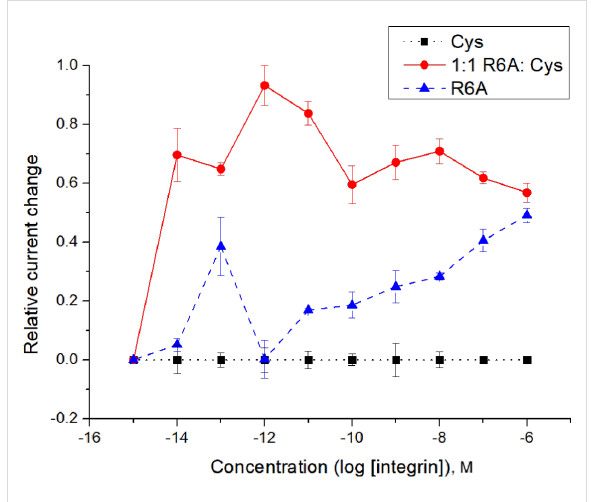
Figure 10: An initial study and the comparison of an R6A surface and a 1:1 R6A/cysteine methyl ester